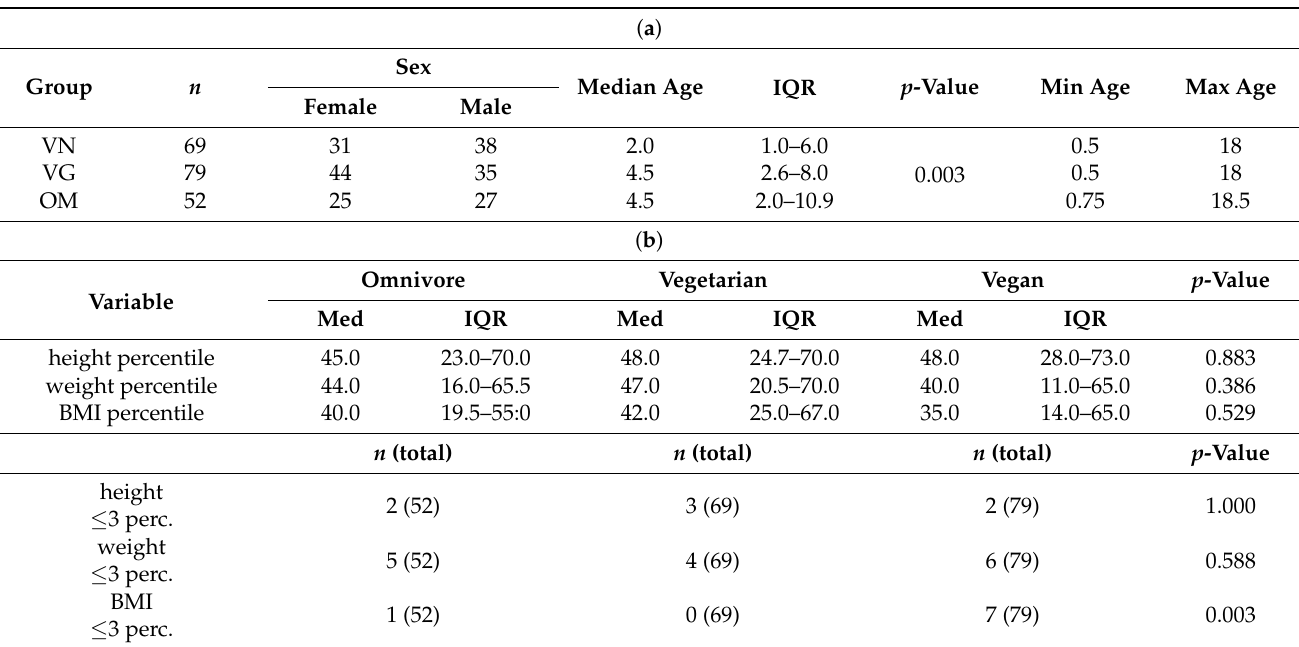
Table 3. ( a ) Description of the basic characteristics of VG/VN/OM group. ( b ) Description of the basic characteristics of VG/VN/OM group.